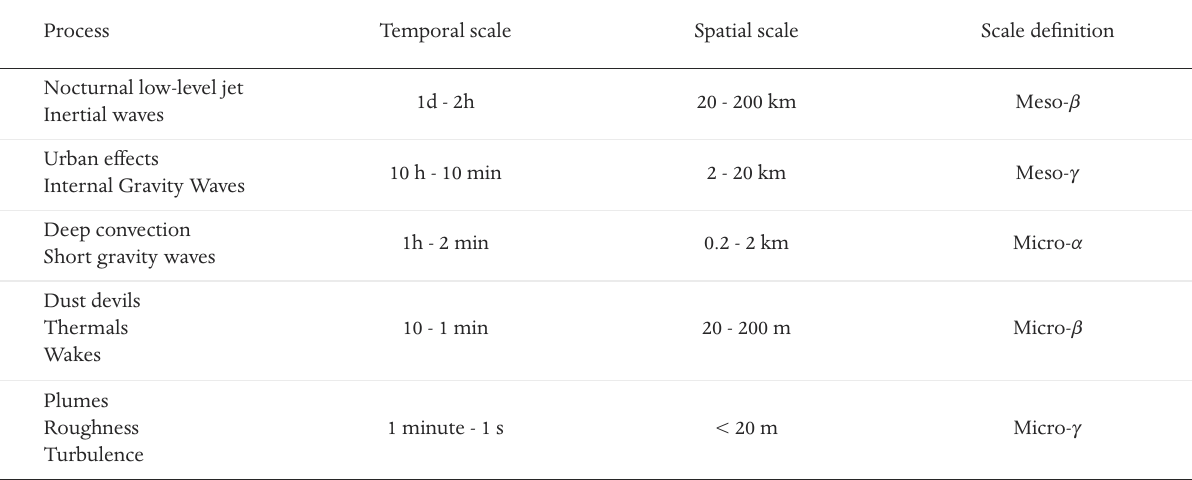
Table 1. Scales of atmospheric processes involved in the PBL. Adapted from Orlanski [1975].